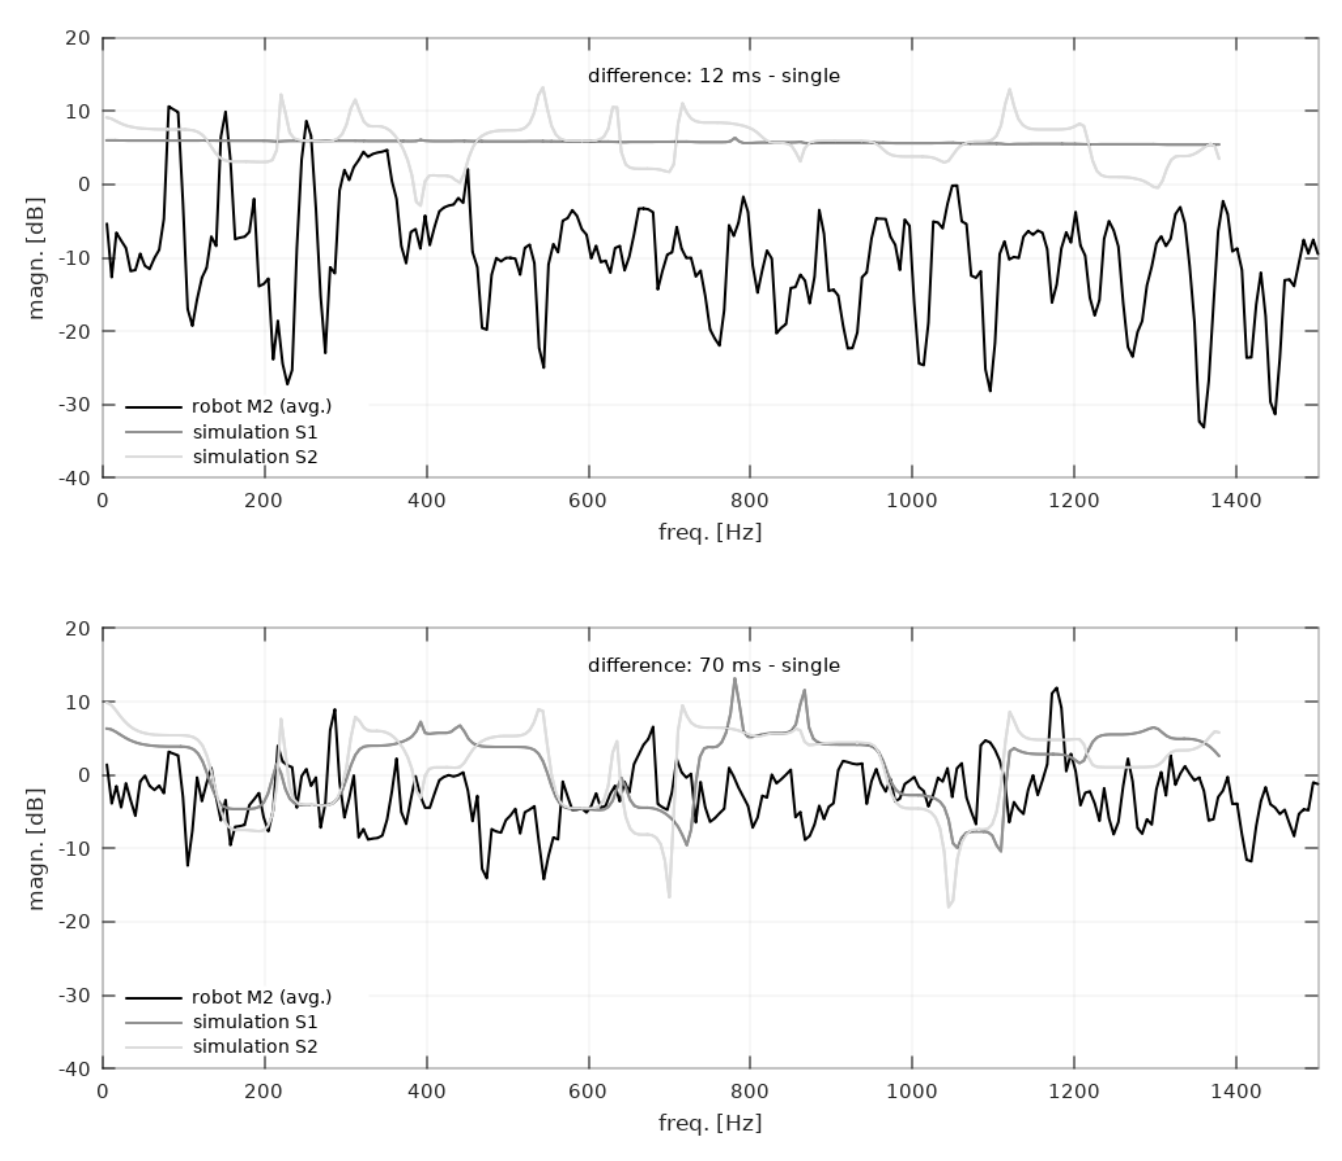
Figure 11. Spectral changes for two values of short re-excitation delay (12 ms and 70 ms)—comparison of robot measurements (dark plot) and both simulations (medium and